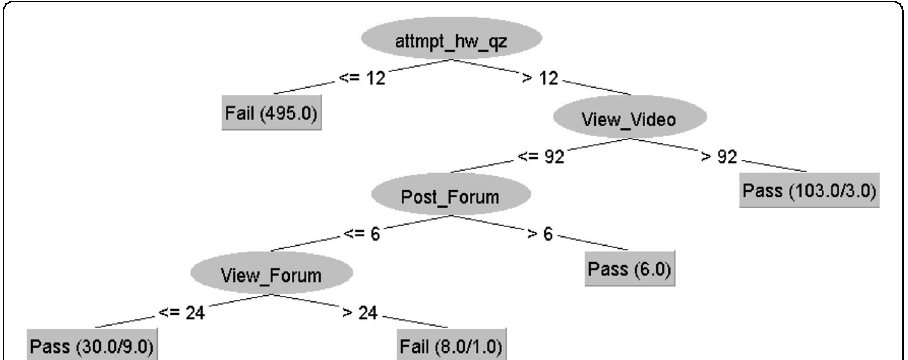
Fig. 2 J48 Decision Tree of Pass/Fail TOL